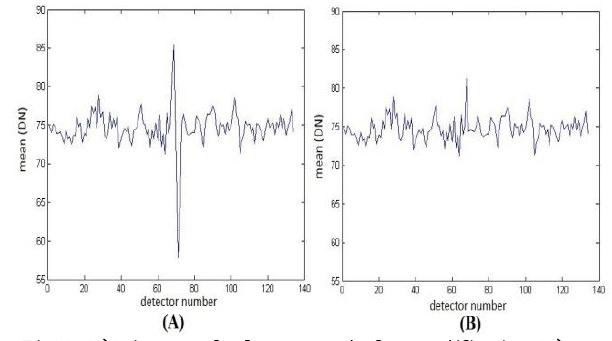
Fig11. A) Diagram of column mean before modification. B) Diagram of the column mean after